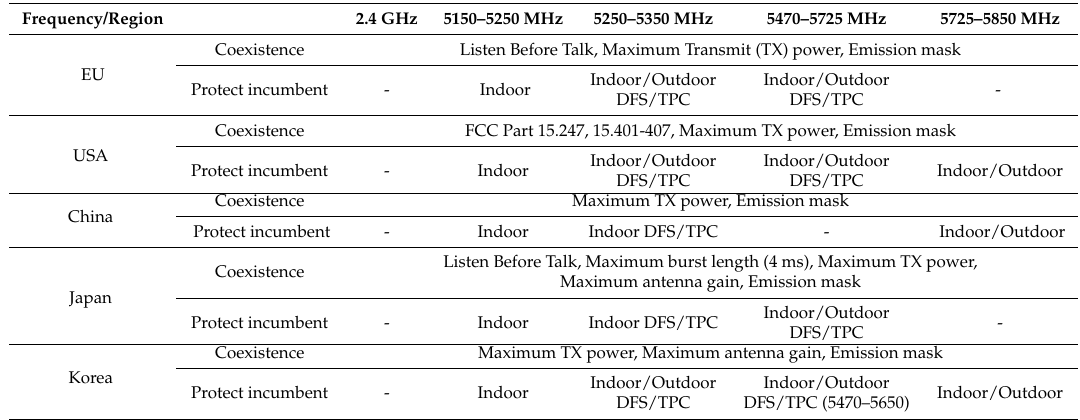
Table 1. Regional requirements for the unlicensed